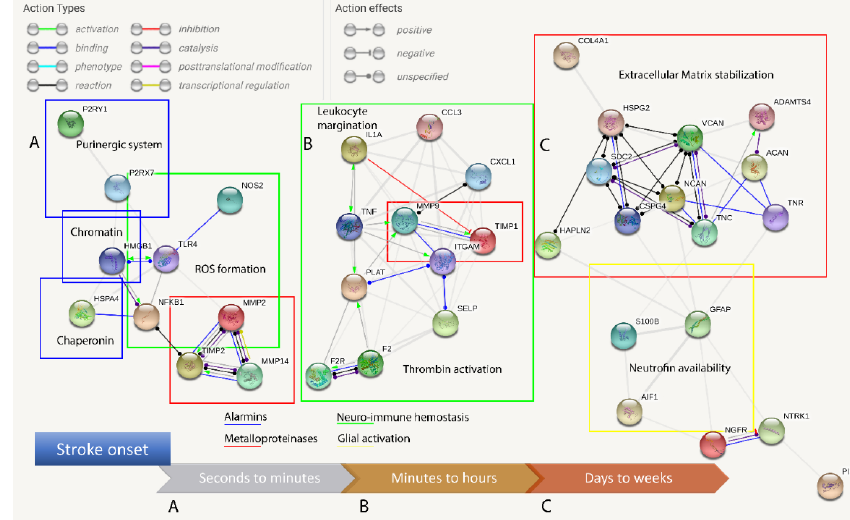
Figure 3. Protein–protein interaction (PPI) maps generated considering the timescale of